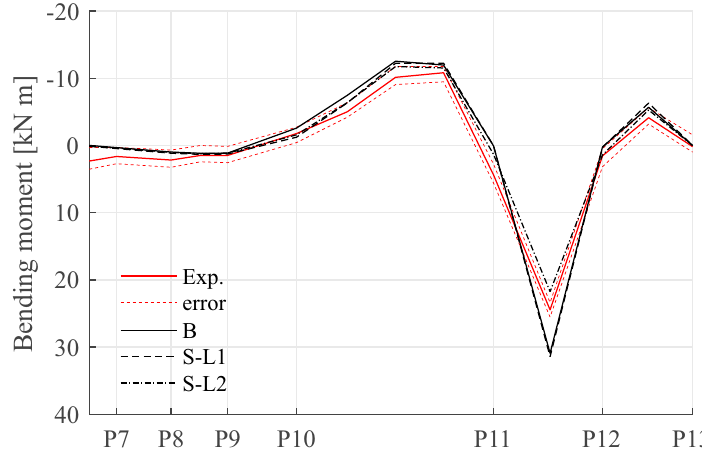
Figure 10. Bending moment influence line at